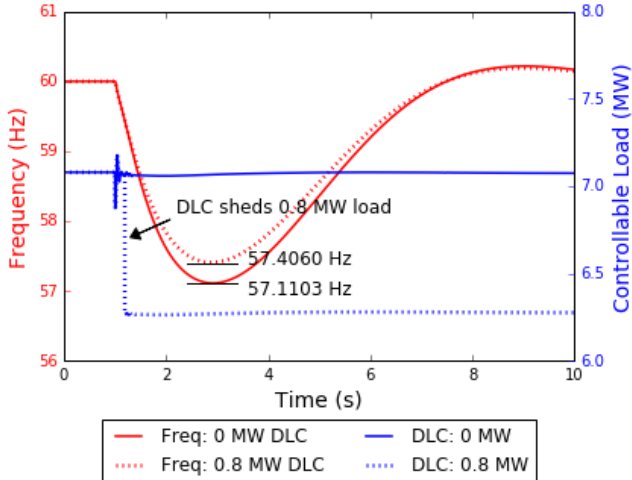
Figure 7. The N -1 contingency simulation with / without DLC load Figure 7. The N-1 contingency simulation with/without DLC load shedding. Table 2. The frequency support capability of DLC–case study.